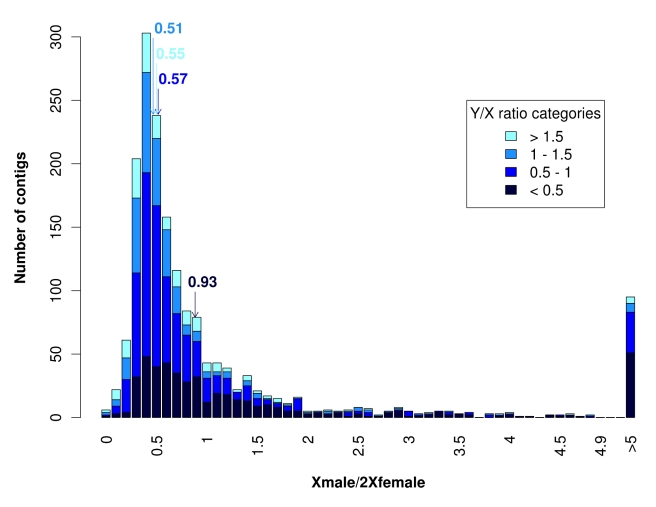
Distribution of the ratio between the expression of the single X in males and the two X copies in females (Xmale/2Xfemale) for all sex-linked contigs.Different categories of sex-linked contigs are shown: Y/X ratio below 0.5 (379 contigs), Y/X ratio between 0.5 and 1 (656 contigs), Y/X ratio between 1 and 1.5 (315 contigs), Y/X ratio above 1.5 (195 contigs). Medians are indicated in the colour corresponding to each Y/X ratio category. When the contigs with high Xmale/2Xfemale ratios are removed as in Figure 3 (see text for explanations) the medians remain unaltered except for the category Y/X<0.5 where it changes to 0.76 but is still significantly different from 0.5 (Wilcoxon test, p<10−16). Total X read numbers were summed at sex-linked SNP locations in each contig and normalized for each individual separately, then averaged among males and females to get the Xmale/2Xfemale ratio.